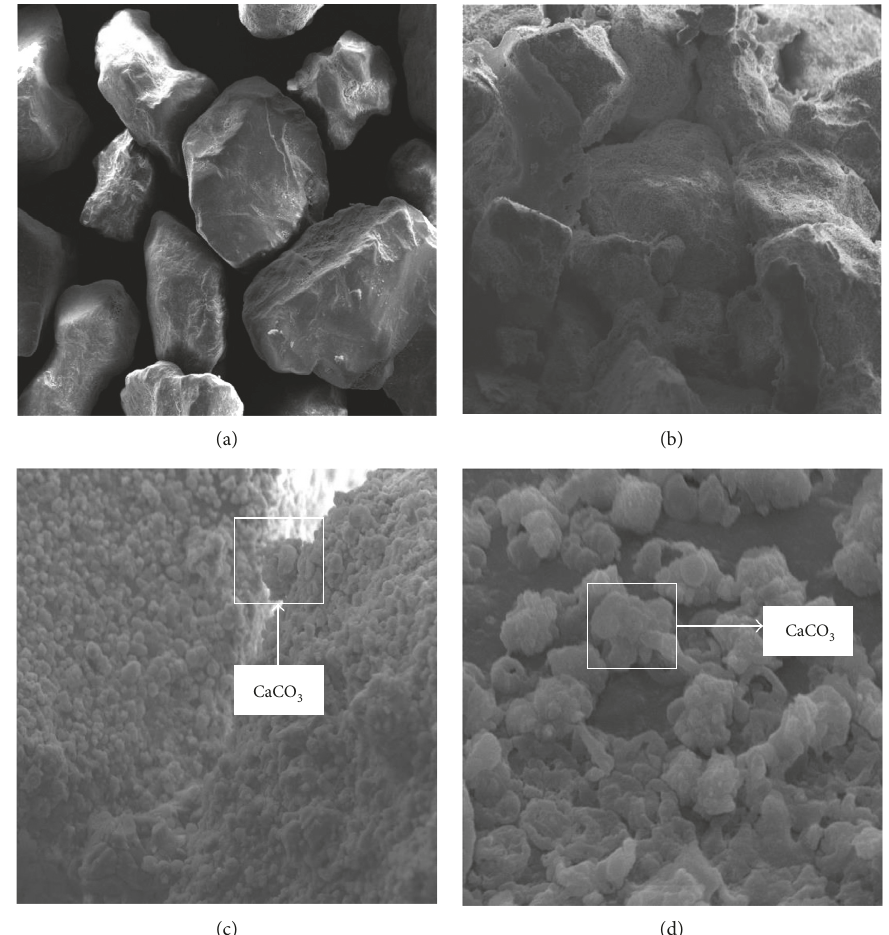
Figure 9: SEM images of sands: (a) untreated sands with magnification at 300x; (b) treated sands with magnification at 300x; (c) treated sands with magnification at 1500x; (d) treated sands with magnification at 10000x.